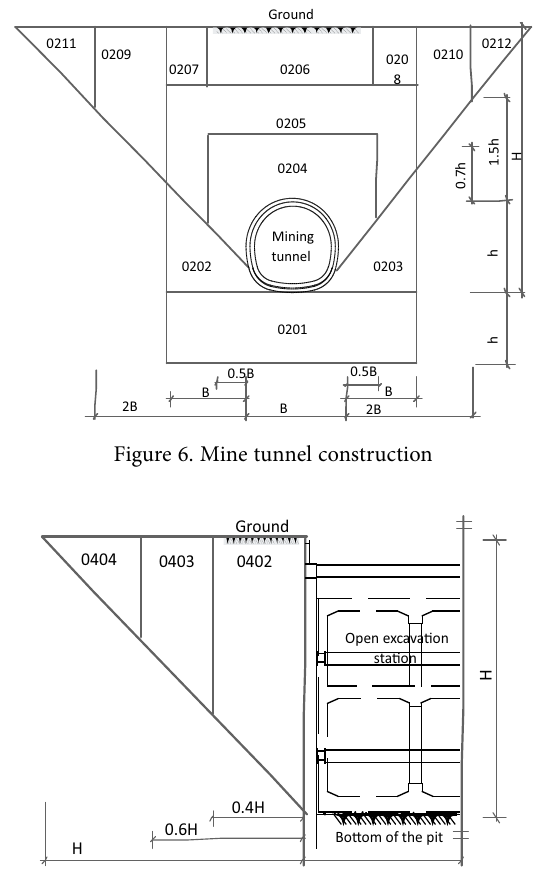
Figure 7. Pile-Beam-Arch (PBA) station construction Figure 8. Open excavation station